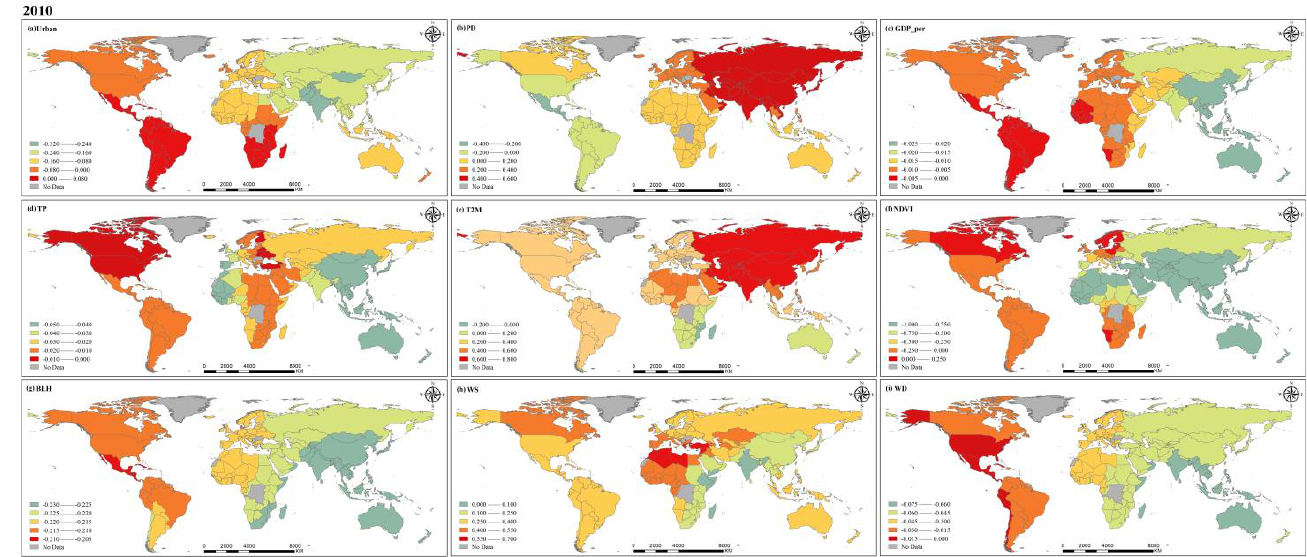
Figure 14. Spatial distribution of coefficients for factors in 2010.